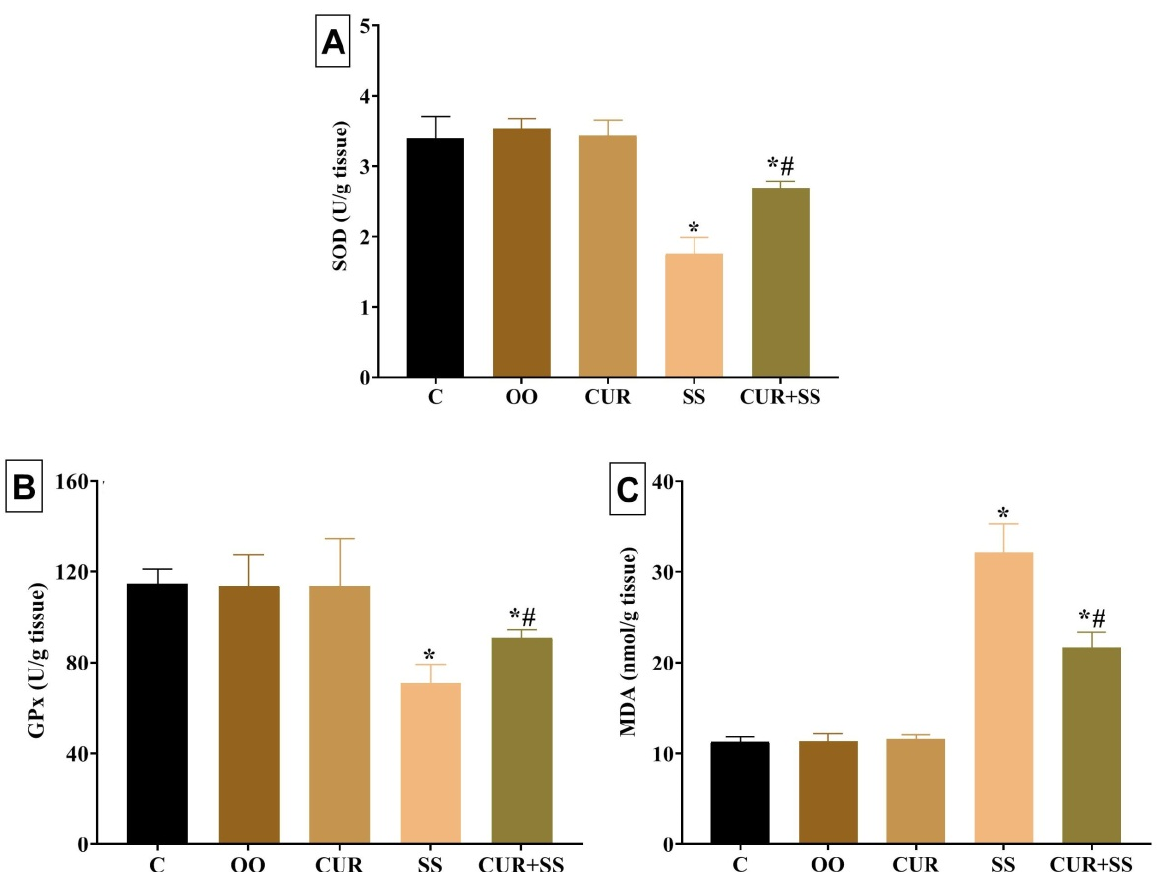
Figure 1. Effect of curcumin (CUR) oral dose on ( A ) superoxide dismutase (SOD), ( B ) glutathione peroxidase (GPx), and ( C ) malondialdehyde (MDA) in the kidney tissues of sodium salicylate (SS)-injected rats for 15 days. C: control group. OO: olive oil. Data are expressed as mean ± SD, n = 10 for each group. * Significantly different compared to the control groups at p < 0.05. # Significantly different from the SS-treated group at p < 0.05.